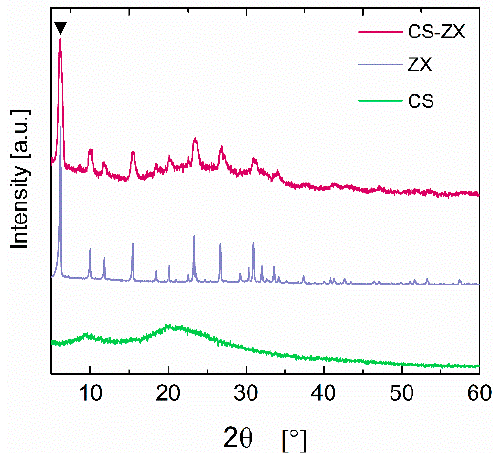
Figure 2. XRD patterns of ZX, CS and CS–ZX samples. Peak at 2 θ = 6.228° is characteristic of zeolite 13X.